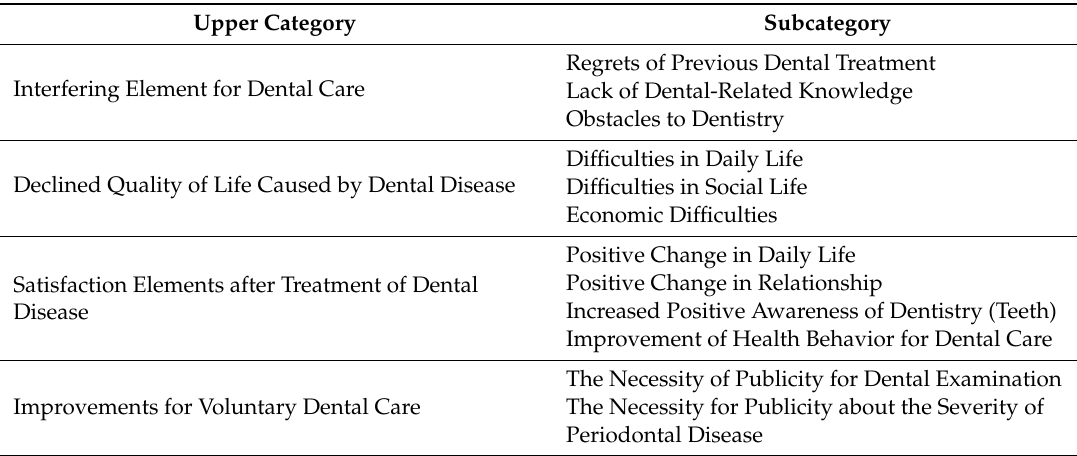
Table 2. Categorization